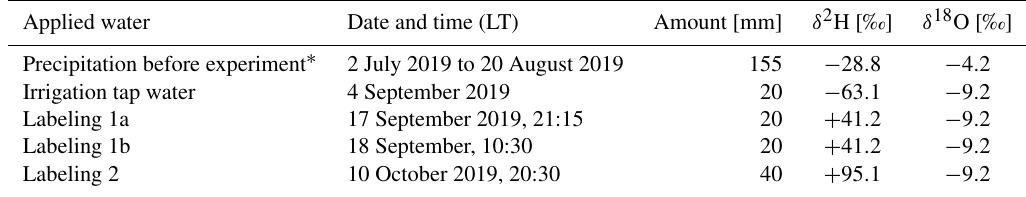
Table 2. Characteristics of the irrigation and labeling water during the experiment. (Note that the first labeling was split into labeling 1a and 1b to better monitor the response in soil moisture. During the second labeling this procedure was no longer necessary.) Applied